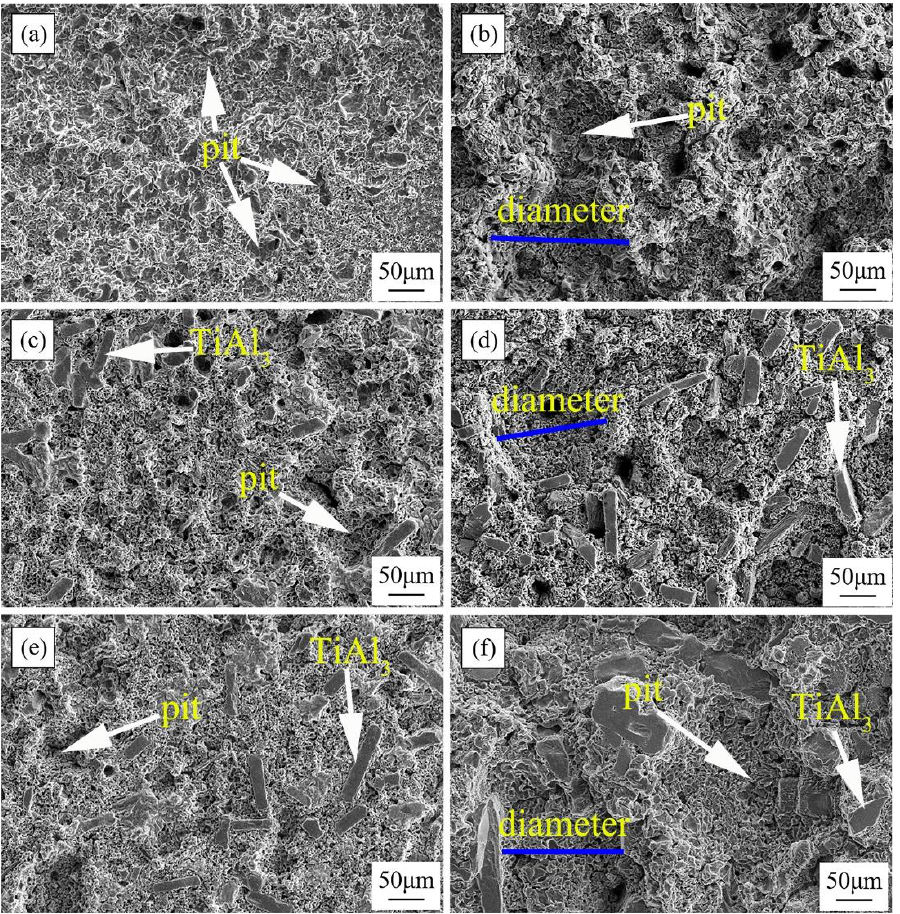
Figure 6. Surface morphology of Al, Al–5Ti, and Al–10Ti alloys after cavitation erosion for 120 min and 300 min; ( a , c , e ) are the morphologies of Al, Al–5Ti, and Al–10Ti alloys after cavitation erosion for 120 min, respectively; ( b , d , f ) are the morphologies of Al, Al–5Ti, and Al–10Ti alloys after cavitation erosion for 300 min, respectively.